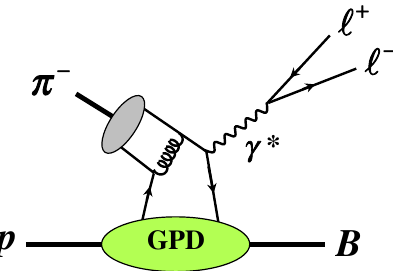
Figure 13. Exclusive Drell–Yan process.